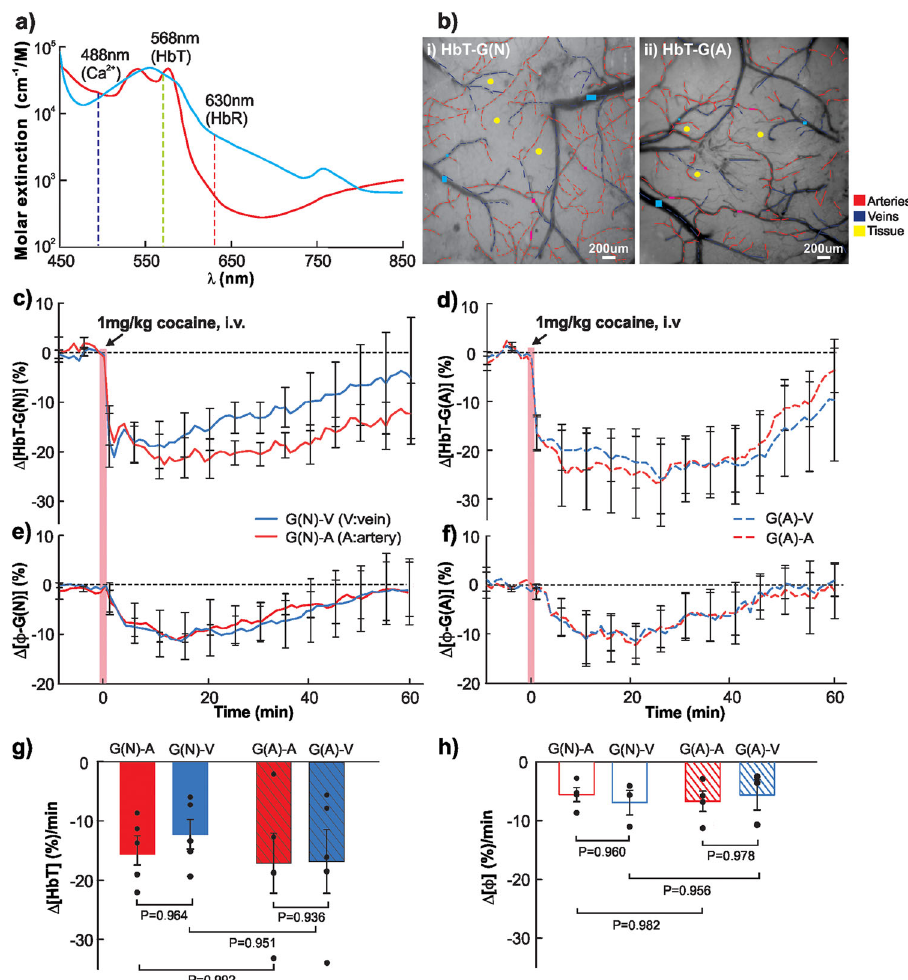
Fig. 2 Cocaine-induced total hemoglobin (i.e., blood volume) and vessel diameter changes in veins and arteries of mouse brains in vivo. a Absorption spectra of oxygenated-hemoglobin (HbO 2 , red curve) and deoxygenated-hemoglobin (HbR, blue curve). Besides λ ex = 488 nm for excitation of cellular GCaMP6f Ca 2 + fl uorescence, λ 1 = 568 nm and λ 2 = 630 nm were selected in multimodality imaging platform to retrieve changes in HbO 2 and HbR, thus HbT in cortical tissue as well as within vessels. b Spectral images of the cortex at λ 1 = 568 nm in WT mouse (i) and GFAP-Cre mouse (ii) with separation of arteries (red traces) and veins (blue traces). Regions of interest (ROIs) were selected from arteries (e.g., pink dots), veins (e.g., blue dots) and tissue (e.g., yellow dots) from each animal. c , d Time courses of Δ [HbT] in arteries (red) and veins (blue) in response to cocaine (1 mg/kg, i.v.) in neuronal ( c ) and astrocytic ( d ) GCaMP6f-expressing animals ( n = 5/group), both showing long-persistent decreases in arteries and veins by cocaine. e , f Vascular diameter ( ΔΦ ) changes in arteries (red) and veins (blue) as a function of time after cocaine injection (1 mg/kg, i.v.) in neuronal and astrocytic groups, respectively. g Comparisons of Δ [HbT]% decrease per minute between arteries and veins in the neuronal and astrocytic GCaMP6f-expressing animals ( n = 5/group), showing no signi fi cant difference between arteries and veins in either group. h Comparisons of ΔΦ % decrease per minute between arteries and veins in neuronal and astrocytic GCaMP-expressing groups, showing no signi fi cant difference of ΔΦ % in response to cocaine. All error bars are presented as means ±